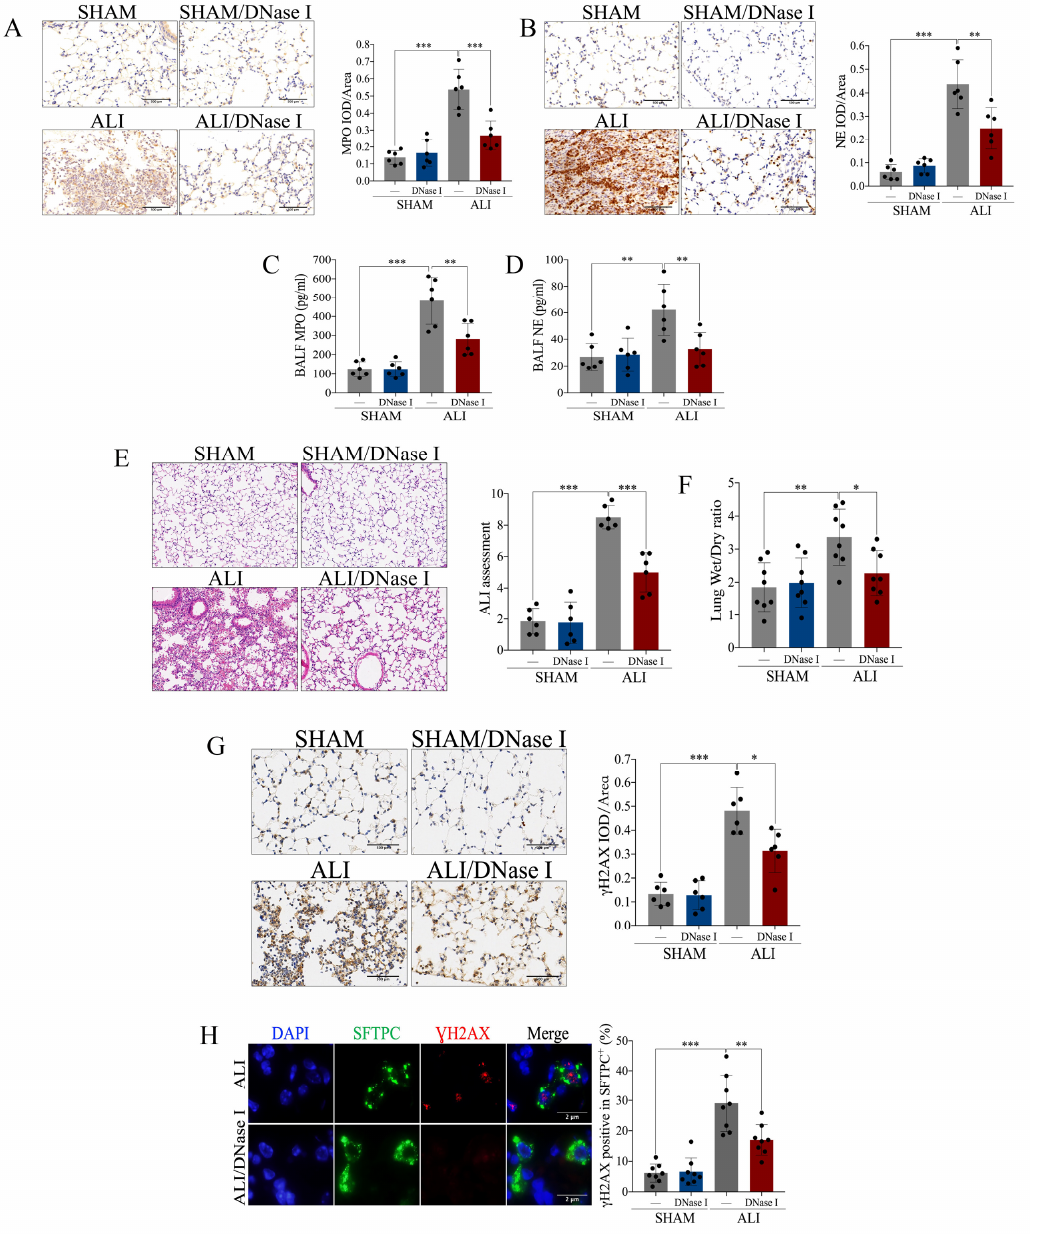
Figure 2. Pharmacological degradation of NETs confers protection against LPS-induced acute lung injury. NET inhibitor DNase I (20 mg/kg) was intravenously injected 1 h after LPS treatment. ( A ) Representative images of the immunohistochemical staining of MPO (scale bar = 500 µ m), and statistics of the positive signal of MPO in lung tissue. ( B ) Representative images of immunohistochemical staining of NE (scale bar = 500 µ m), and statistics of the positive signal of NE in lung tissue. ( C ) Con- centration of MPO in BALF. ( D ) Concentration of NE in BALF. ( E ) Representative images of H&E staining of lung tissue (X100), and ALI assessment score. ( F ) Lung wet weight-to-dry weight ratio. ( G ) Representative images of immunohistochemical staining of γ H2AX in lung tissue (scale bar = 500 µ m), and statistics of the positive signal of γ H2AX in lung tissue. ( H ) Representative images of immunofluorescence co-localization of SFTPC and γ H2AX (scale bar = 2 µ m), and the percentage of γ H2AX-positive SFTPC+ cells. Data are presented as the mean ± SD, n = 6–8 per group. * p < 0.05, ** p < 0.01, *** p < 0.001. Comparisons between two groups were analyzed by an unpaired t test; otherwise, one-way analysis of variance was performed, and Tukey’s test was used to perform pairwise